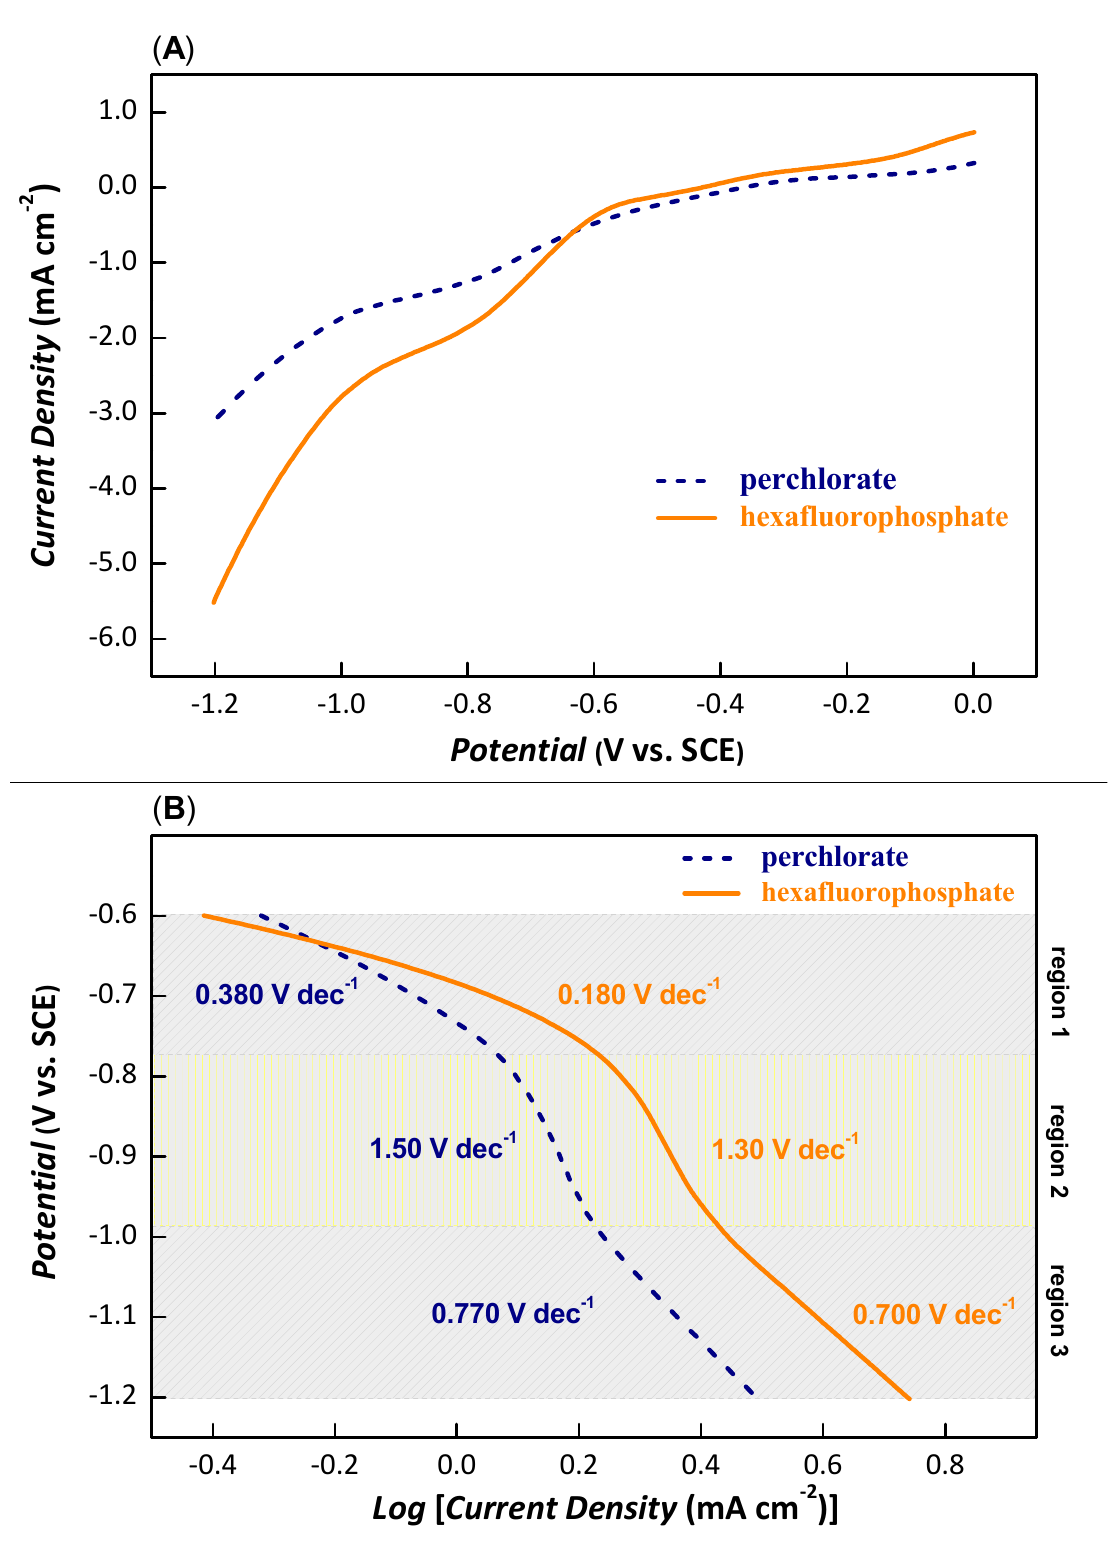
Figure 5. ( A ) Electrocatalytic response in the presence of CO 2 -saturated 0.50 mol L − 1 KCl solution at 25 mV s − 1 of poly-Pd(salen) films electropolymerized with perchlorate (blue dashed line) and hexafluorophosphate (orange line) anions. ( B ) Polarization curves for the electroreduction of carbon dioxide.